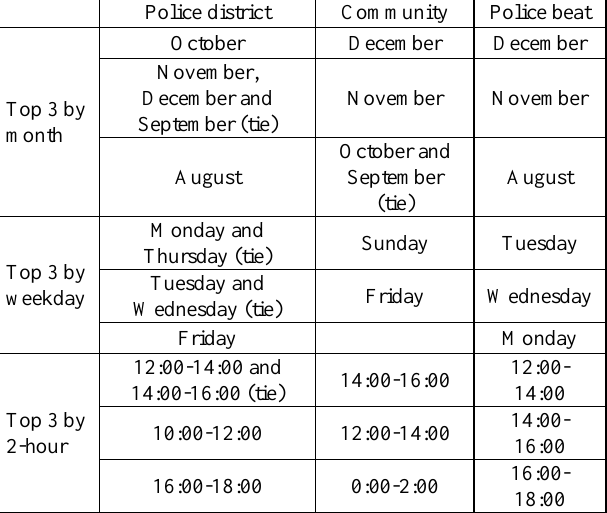
Table 1. Time intervals with most clusters value cluster for nine months. At the weekday temporal level, as seen from Figure 7, high value clusters concentrate in the middle to south parts as well. All the weekdays have high value clusters. The same district with clusters for nine months has the highest weekday frequency. At the two-hour interval level (Figure 8), the concentration of high value cluster slightly expands to both south and